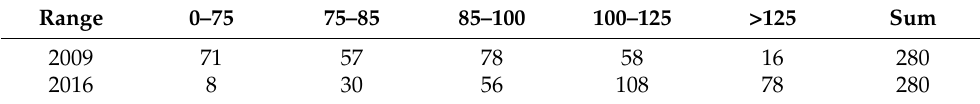
Figure 5. PCI values of 280 prefecture-level cities in China in 2009 ( a ) and 2016 ( b ). Table 3. Number of cities with PCI values in different